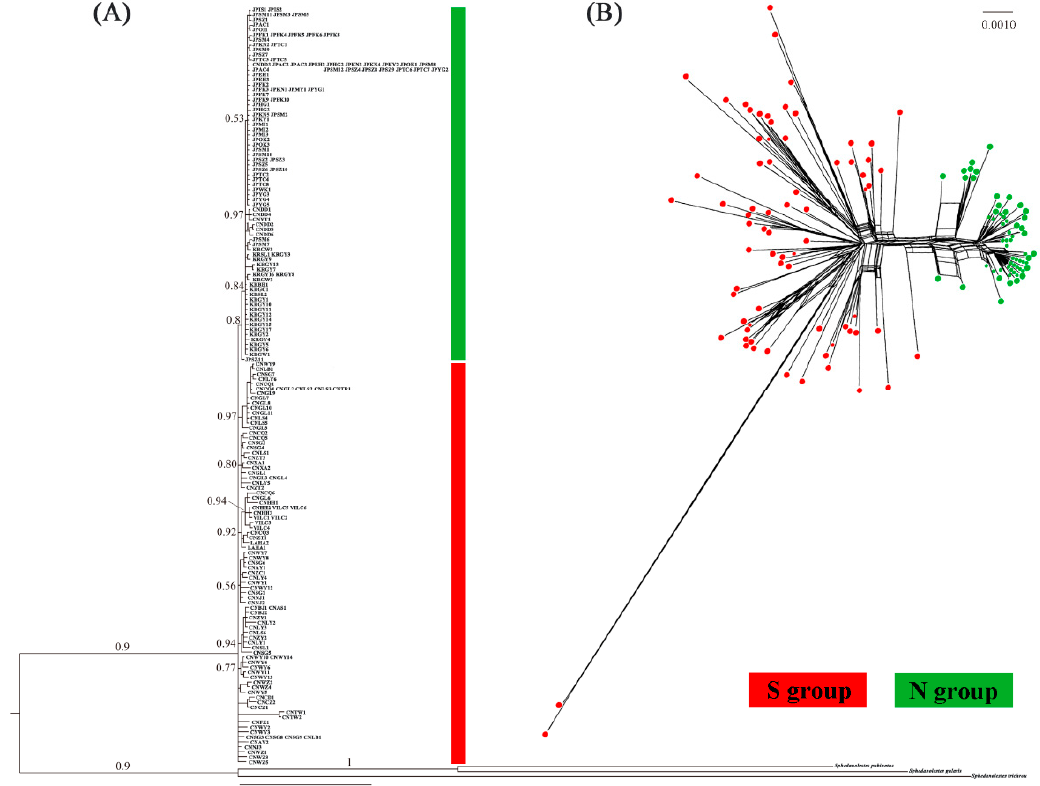
Figure 2. ( A ) Bayesian tree based on concatenated mitochondrial haplotypes. Bayesian posterior probabilities are shown at each node. Population codes are listed in Table S1. ( B ) Split network based on the concatenated mitochondrial dataset.